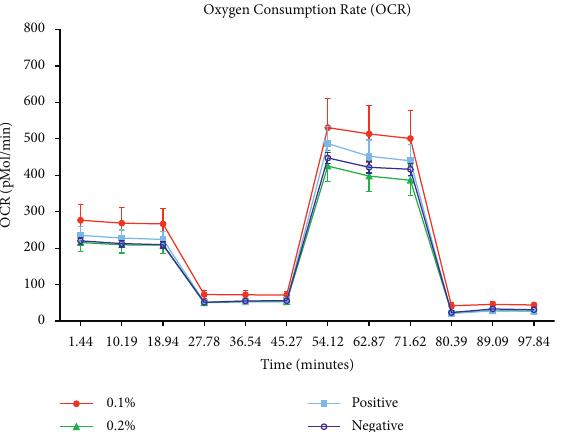
Figure 3: Results of the mitochondrial oxygen consumption rate (OCR) assay and a graph of the Seahorse XF Mito Stress Test profile, showing mean (and SEM) OCR values at given time